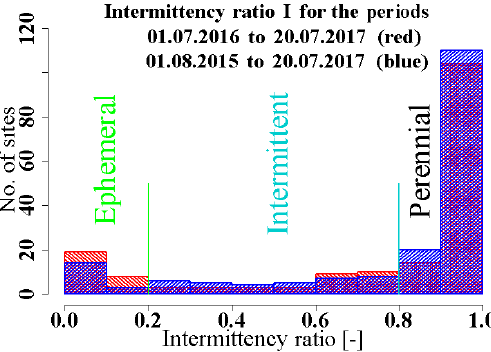
Figure 4. Intermittency ratio of the periods 1 July 2016– 20 July 2017 (red) and 1 August 2015–20 July 2017 (blue). Ac- cording to the classification of Hedman and Osterkamp (1982) the degree of intermittency is indicated for ephemeral, intermittent and perennial streams. The distribution of classes shows a high number of perennial sites compared to ephemeral and